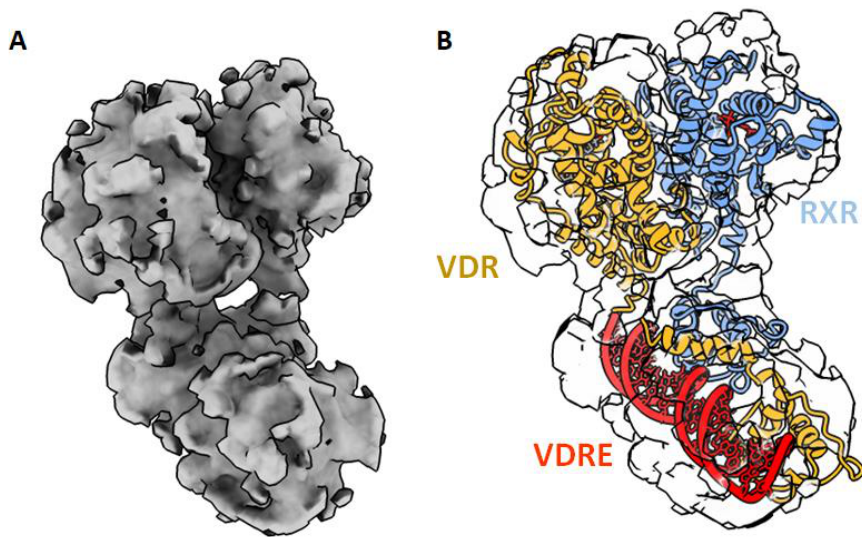
Figure 4. Cryo-EM structure of the VDR–RXR on DNA. ( A ) Electron density map shown as surface. ( B ) Fitted atomic model of the heterodimer in the EM map [59].